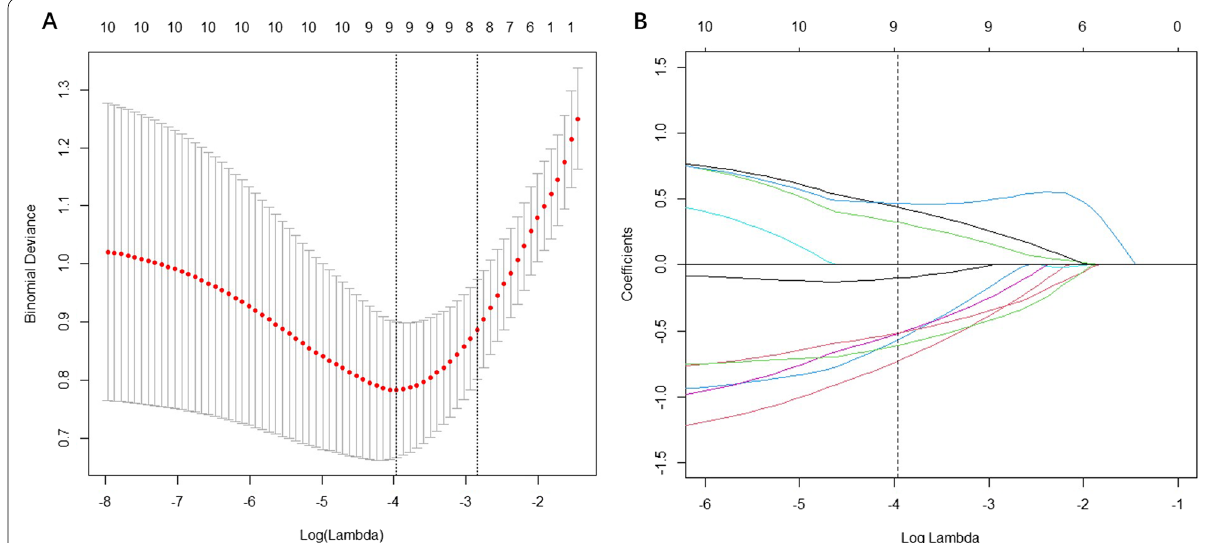
Fig. 2 LASSO algorithm and tenfold cross-validation were used to extract the optimal subset of radiomics features. a Optimal tuning parameter (lambda) selection according to partial likelihood deviation of the model. b LASSO coefficient profiles of the 10 features. Using the tenfold cross-validation, a vertical line was drawn at the selected value and nine non-zero coefficients are shown